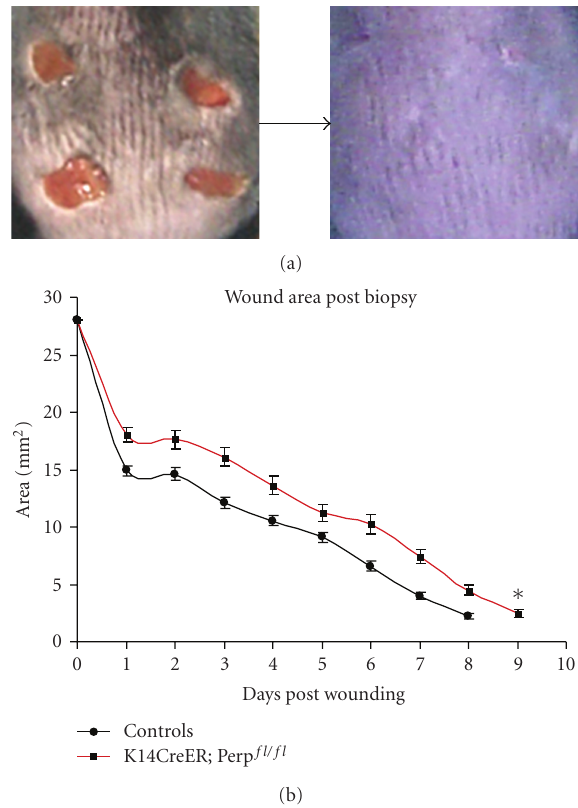
Figure 2: Loss of Perp delays wound healing in vivo . (a) Represen- tative photos of dorsal skin bearing open wounds at the beginning of the study and fully closed wounds at the end of the study. (b) Graph displays the average area of all wounds as a function of time post-biopsy. Combined controls: n = 64 wounds amongst 16 mice. K14CreER; Perp fl/fl mice: n = 32 wounds amongst 8 mice. Error bars represent the SEM. Statistical significance was determined using ANOVA ∗ = P < .